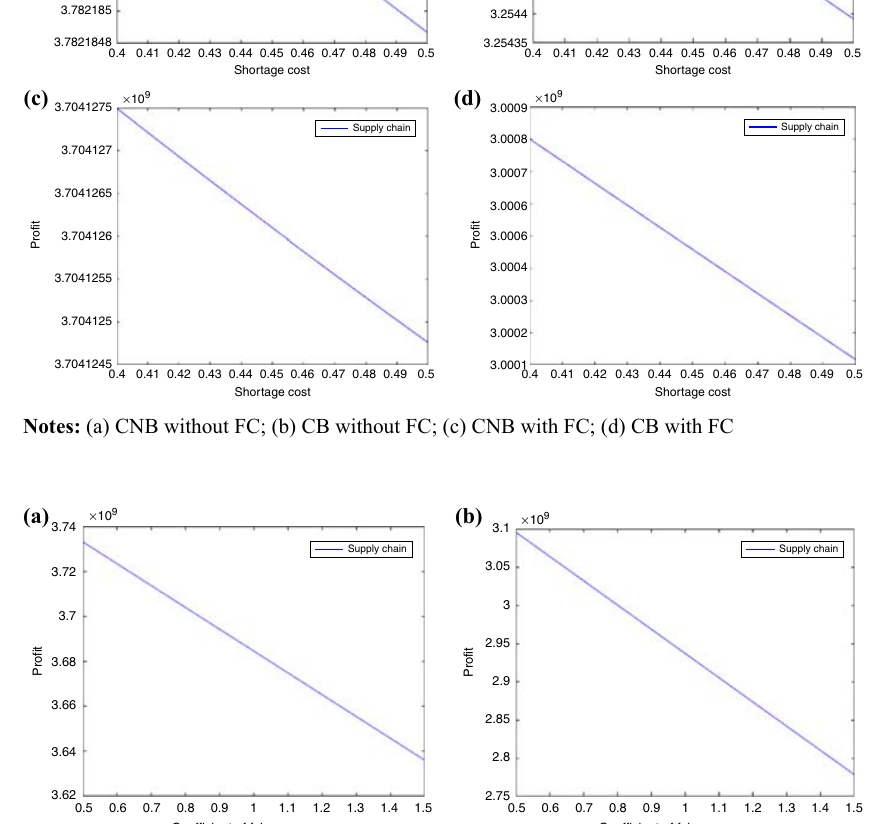
Figure 9. The impact of coefficient of fairness concern change on the profit of IBWT supply chain with fairness concern